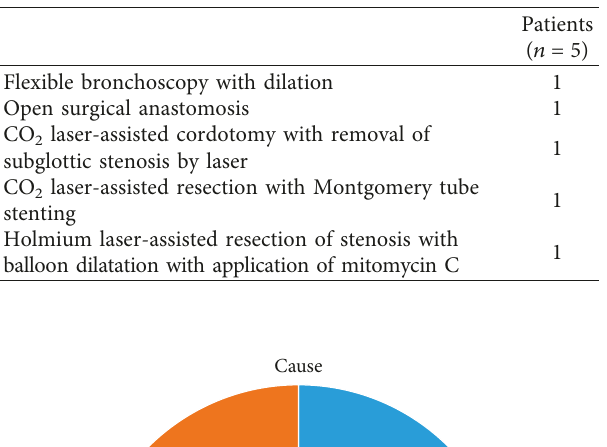
Table 4: Treatment modalities.